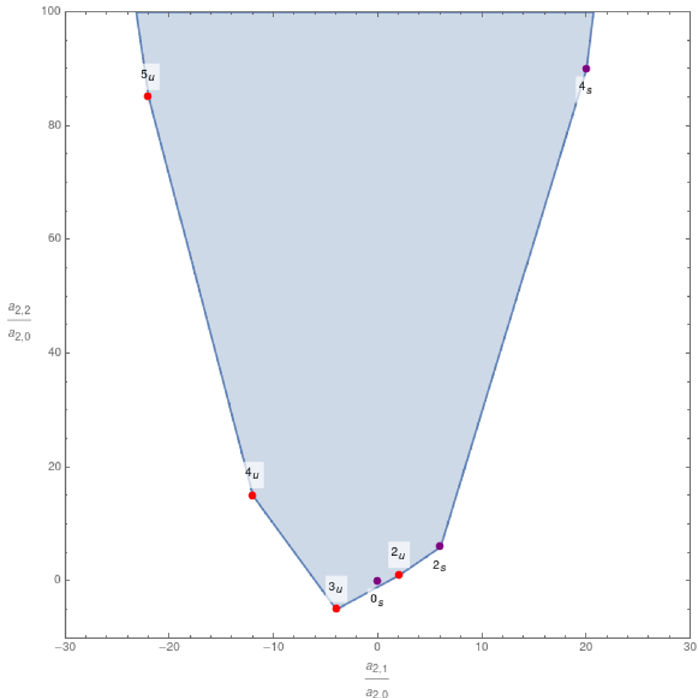
Figure 15 . The k = 2 polygon for ( − − ++) photon scattering. It is bounded by the Minkowski sum of the vectors originated from the s -channel (purple dots) and u -channel (red